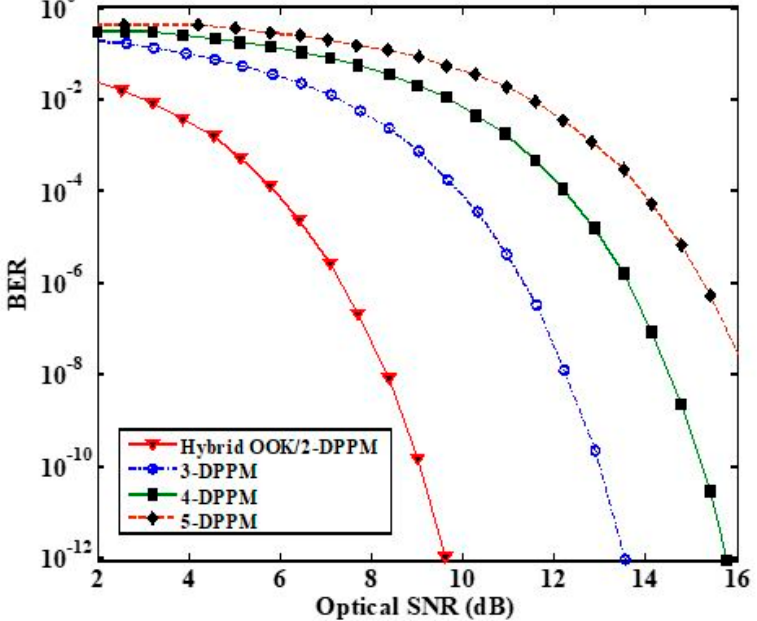
Figure 5. BER vs. OSNR (dB) for the WDM-PON/HFFSO link with hybrid OOK/M-ary DPPM and M-DPPM using D RX = 25 mm, M = 5, l fso = 4000 m for ST. HFFSO optical fiber network, respectively at a target BER of 10 (cid:2879) 12 . The ST without the